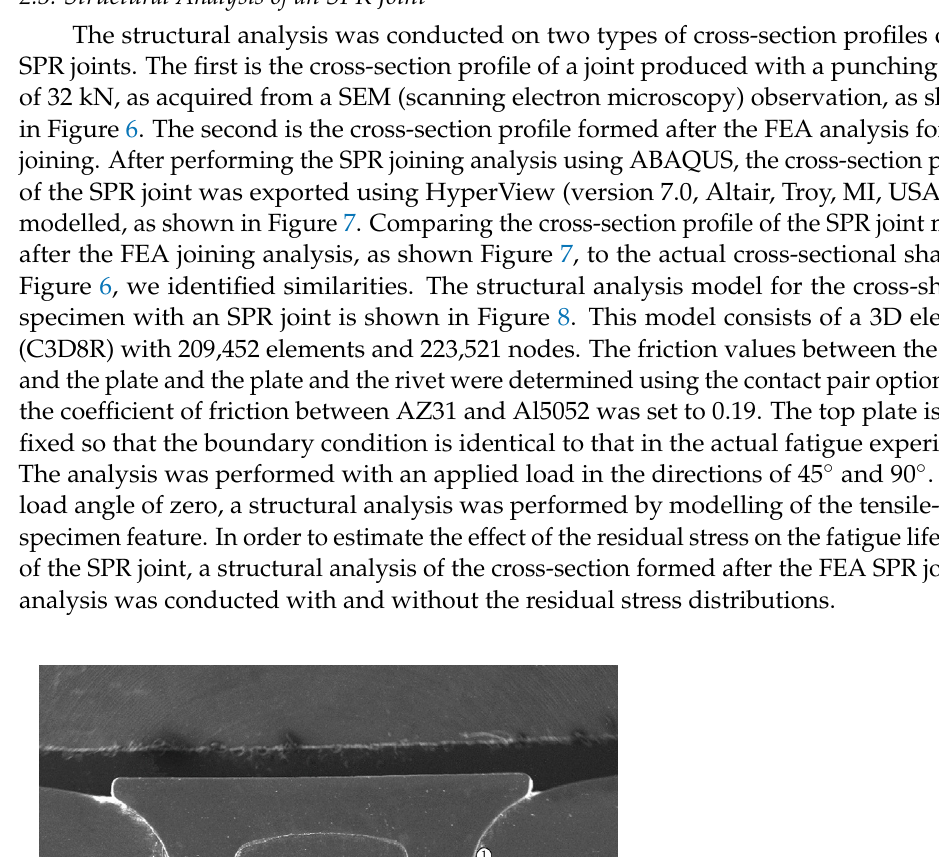
Figure 7. Overview of FE models and a detail SPR joint for the cross-shaped specimen. Piercing 05000100001500020000250003000035000 0